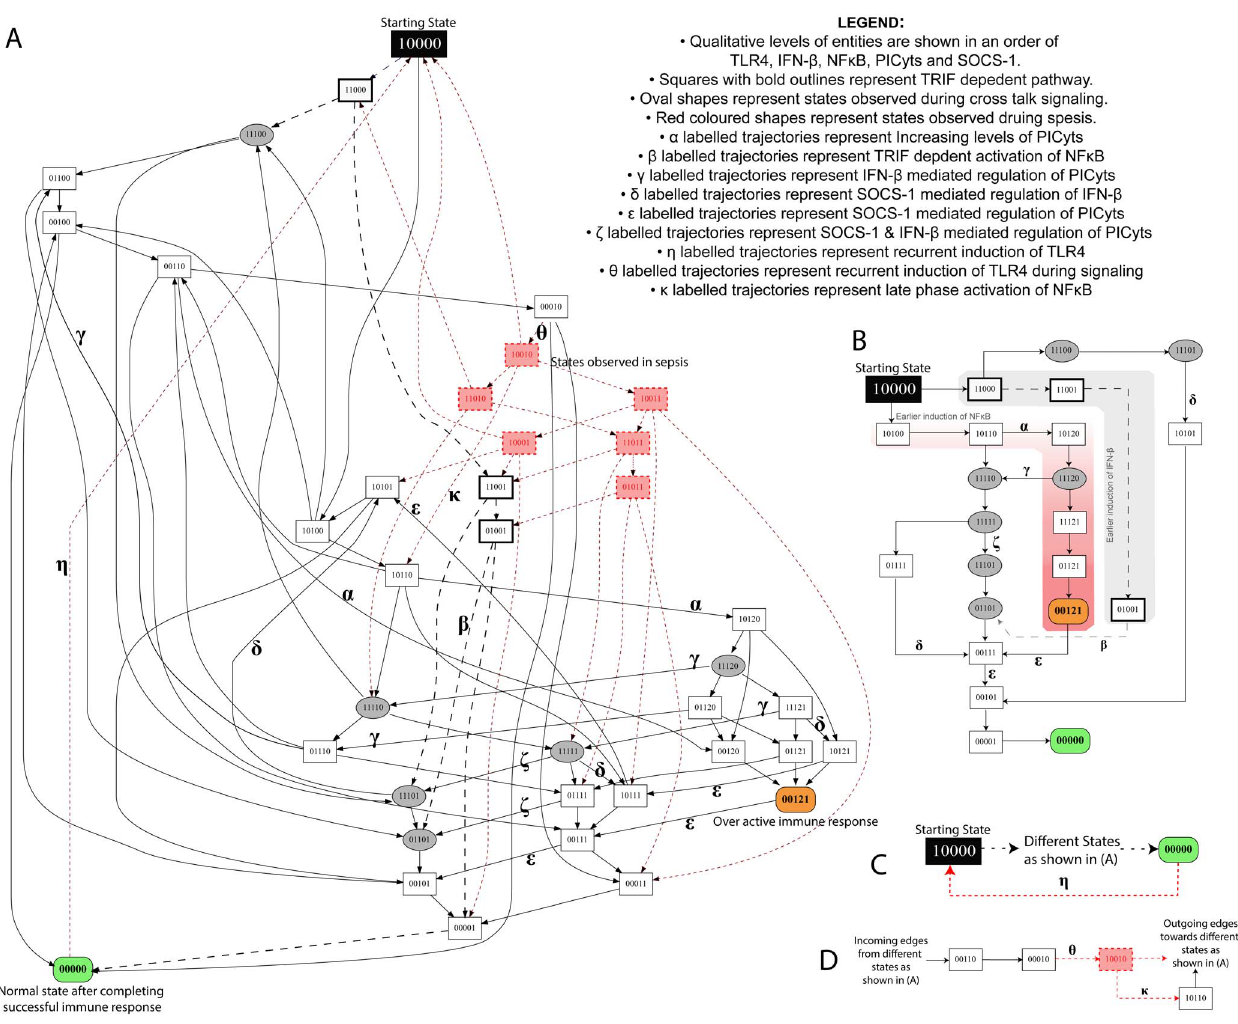
Figure 3. State graph of TLR4 and JAK/STAT signalling during non-septic and septic conditions. (A) Each node represents a particular state observed during signalling associated with non-septic and septic conditions. Integers ‘‘0’’, ‘‘1’’ and ‘‘2’’ within the nodes represent qualitative levels of proteins in the order of TLR4, IFN- b , NF k B, PICyts and SOCS-1. Inactive entities are represented by integer ‘‘0’’ whereas active and overactive entities are represented by integers ‘‘1’’ and ‘‘2’’, respectively. Nodes and trajectories, which were specifically observed during signalling dynamics associated with sepsis, are shown in red, whereas common nodes and trajectories found in both conditions are shown in black. Trajectories start from state ‘‘10000’’, representing the activation of TLR4, and ultimately lead towards ‘‘00000’’, which is a stable state in non-septic condition. On the other hand, a trajectory labelled with ‘‘ g ’’ from state ‘‘00000’’ to starting state ‘‘10000’’ results in a cyclic path during signalling dynamics associated with sepsis. MyD88 and TRIF dependent signalling are shown as black lines and dashed arrows, respectively. Nodes, which represent crosstalk of both signalling pathways i.e. IFN- b and NF k B with qualitative level ‘‘1’’ are presented in oval shapes. Arrows labelled with Greek small letters are used to represent trajectories associated with different signalling events (see legend in the figure). The conditions necessary to produce a state graph shown in the figure are given in Table 1. (B–D) specific states and trajectories which can possibly represent the complete state graph given in (A).